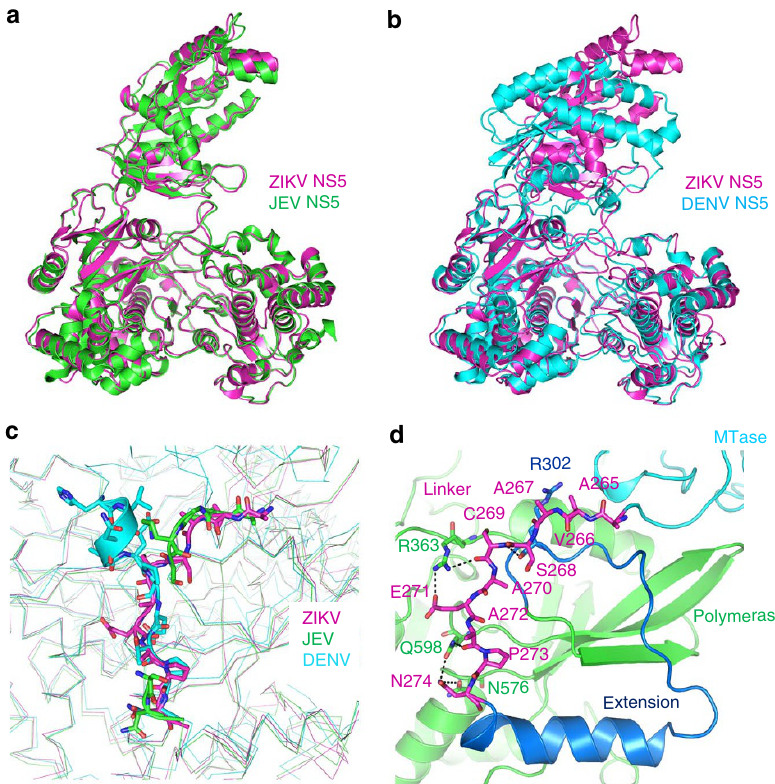
Figure 2 | Comparison of the NS5 structure of ZIKV to those of JEV and DENV. ( a ) Superposition of the structures of ZIKV NS5 with JEV NS5 (PDB, 4K6M). ( b ) Superposition of the structures of ZIKV NS5 with DENV NS5 (PDB, 4V0Q). ( c ) Distinct conformations of the linkers in ZIKV, JEV and DENV NS5 that are responsible for the altered orientations of the MT and RdRp domains in these proteins. The linkers are shown as stick models. The backbones of the MTs and RdRps that flank the linkers are shown as thin lines. Note that several residues of the JEV NS5 linker were not resolved. ( d ) Interactions between ZIKV NS5 linker and the fingers subdomain. The linker is shown as stick models (magenta). The extension (blue), portions of the MT (cyan) and the fingers subdomain (green) are shown as ribbons. Key residues R363, Q598 and N576 from the fingers subdomain that interact the linker are shown as sticks. Dashed lines indicate distance of o